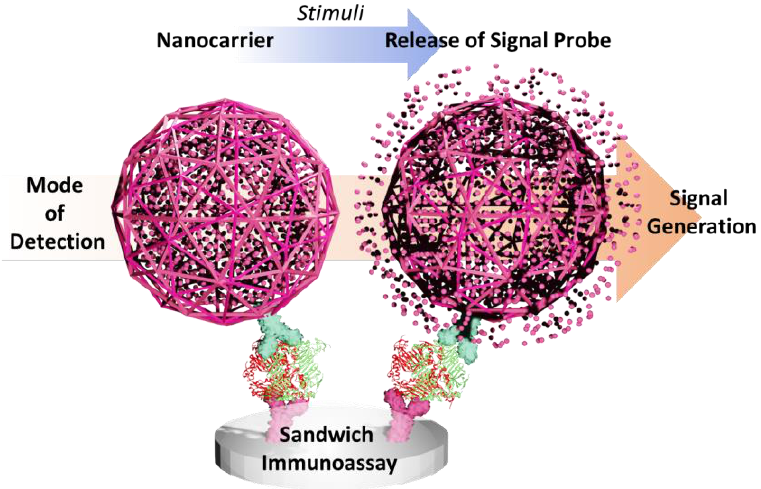
Figure 1. Illustration of a nanosphere-loading signal probe for signal amplification through the formation of the immune sandwich complex and stimuli-mediated cargo release.